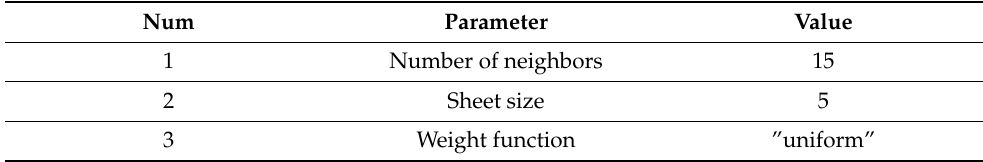
Table 7. Parameters of the k-nearest neighbors model. Num